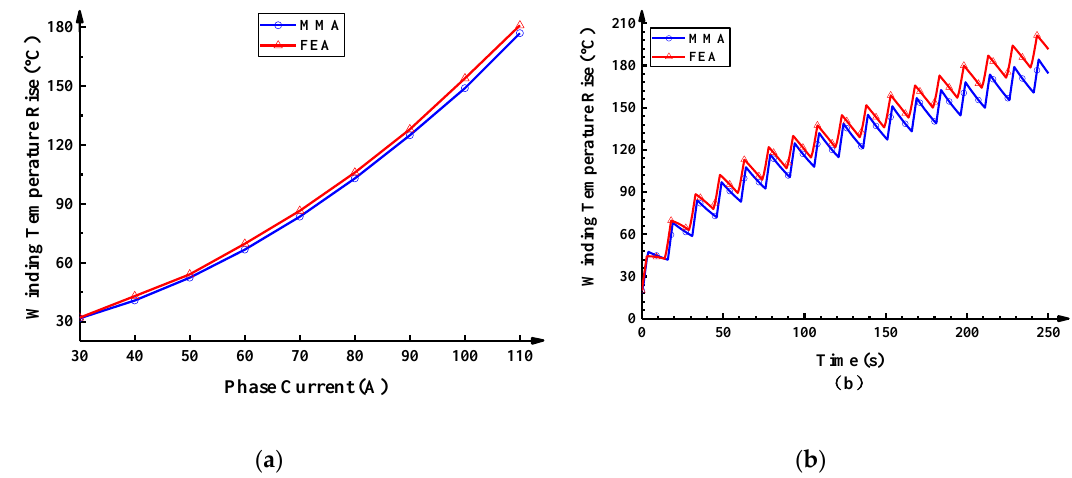
Figure 15. Calculated winding temperatures comparisons ( a ) different current for 20 s ( b ) short-time duty with high-overload.